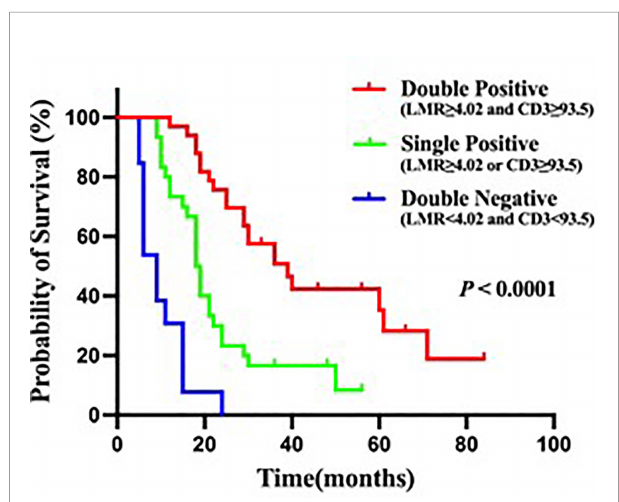
FIGURE 4 | Kaplan-Meier analysis for OS in patients with hilar cholangiocarcinoma. Double positive is LMR ≥ 4.02 and CD3 ≥ 93.5, Single positive is LMR ≥ 4.02 or CD3 ≥ 93.5, Double negative is LMR<4.02 and CD3<93.5.